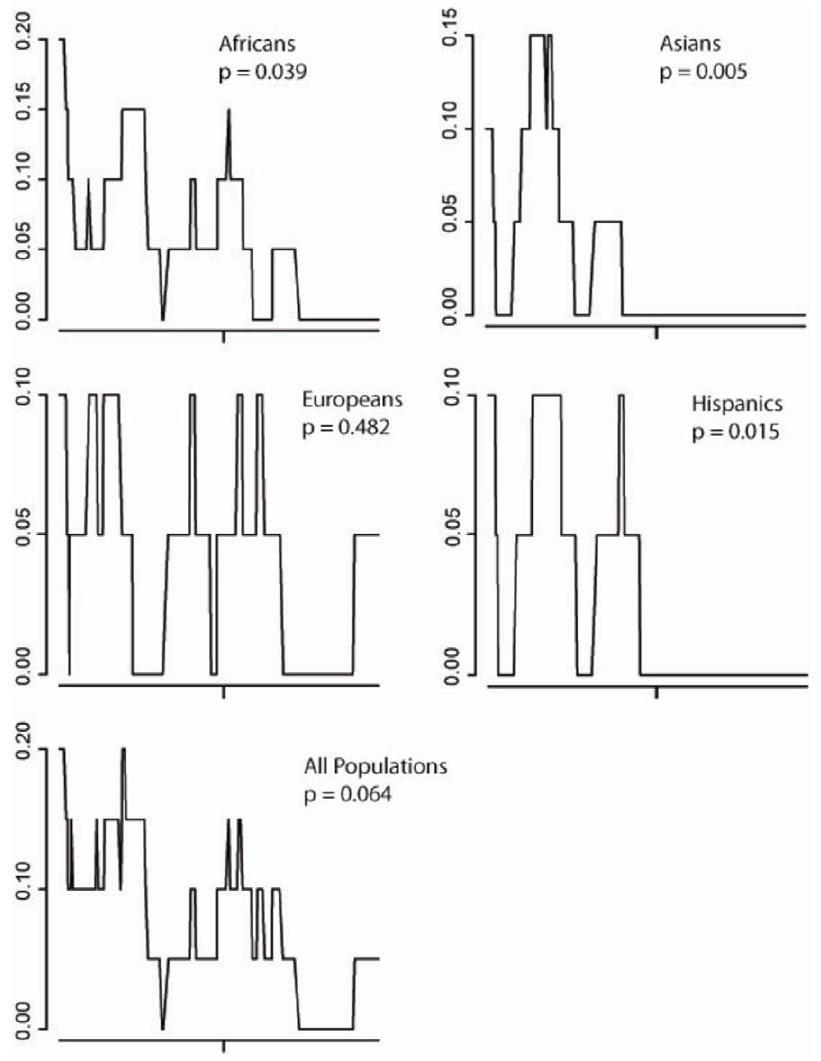
Figure 4. Proportions of polymorphisms to fixed substitutions among humans and rhesus (P/K), calculated by a sliding window approach. Each window includes 20 substitutions. The P value for the Kolmogorov-Smirnoff statistic by McDonald [35] was used to test if the P/K ratio was homogeneous along the gene (see Supplementary File S1 for results using the chimpanzee as outgroup). To be conservative, we evidence the highest P value among those obtained assuming values of recombination parameter r equal to 0, 2, 4 and 6. In the horizontal axes, the vertical tick mark indicates the intron 6- exon 7 boundary. The pattern of significance is the same when Mus musculus or Rattus norvegicus are used as outgroups. Excluding chimpanzee and rhesus; M. musculus and R. norvegicus are the mammals most closely related to humans for which SLC2A4 genomic sequences are available in NCBI databases. doi:10.1371/journal.pone.0009827.g004 selection. The best fit of our data is obtained for models that (see the supplementary File S1 for detailed results): (1) allow for values of v # 1 to vary across SLC2A4 coding region, (2) do not show strong evidence of relaxation of purifying selection along the primate lineages and, (3) do not show evidence of positive allow for K = 2 different classes of v (without restrictions for the value of this parameter) best fit the data, and suggests that , 85% of SLC2A4 codons evolved under strong purifying selection ( v < 0.007) and , 15% under a weaker purifying selection ( v < 0.506, Figure 5). There is no association among the